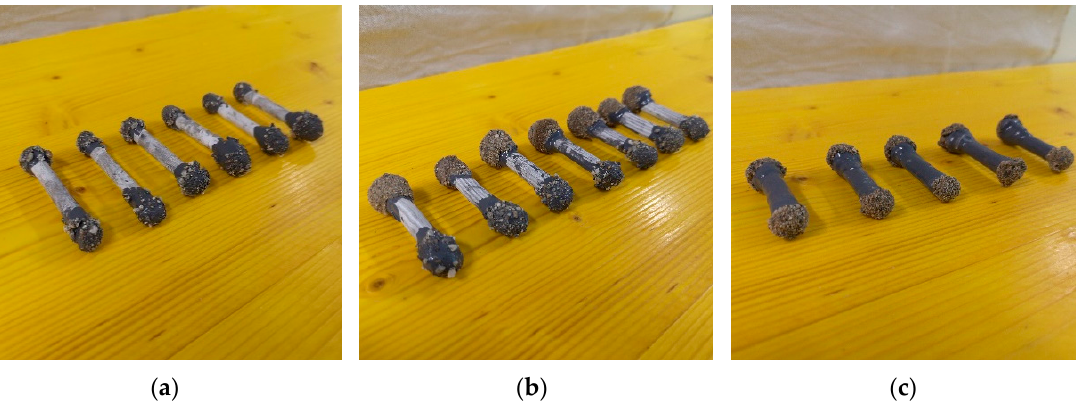
Figure 2. Cementitious capsules after coating, filling and sealing: ( a ) Small-diameter capsules with internal epoxy coating (SI capsules); ( b ) large-diameter capsules with internal epoxy coating (LI capsules); ( c ) large-diameter capsules with external epoxy coating (LE capsules).